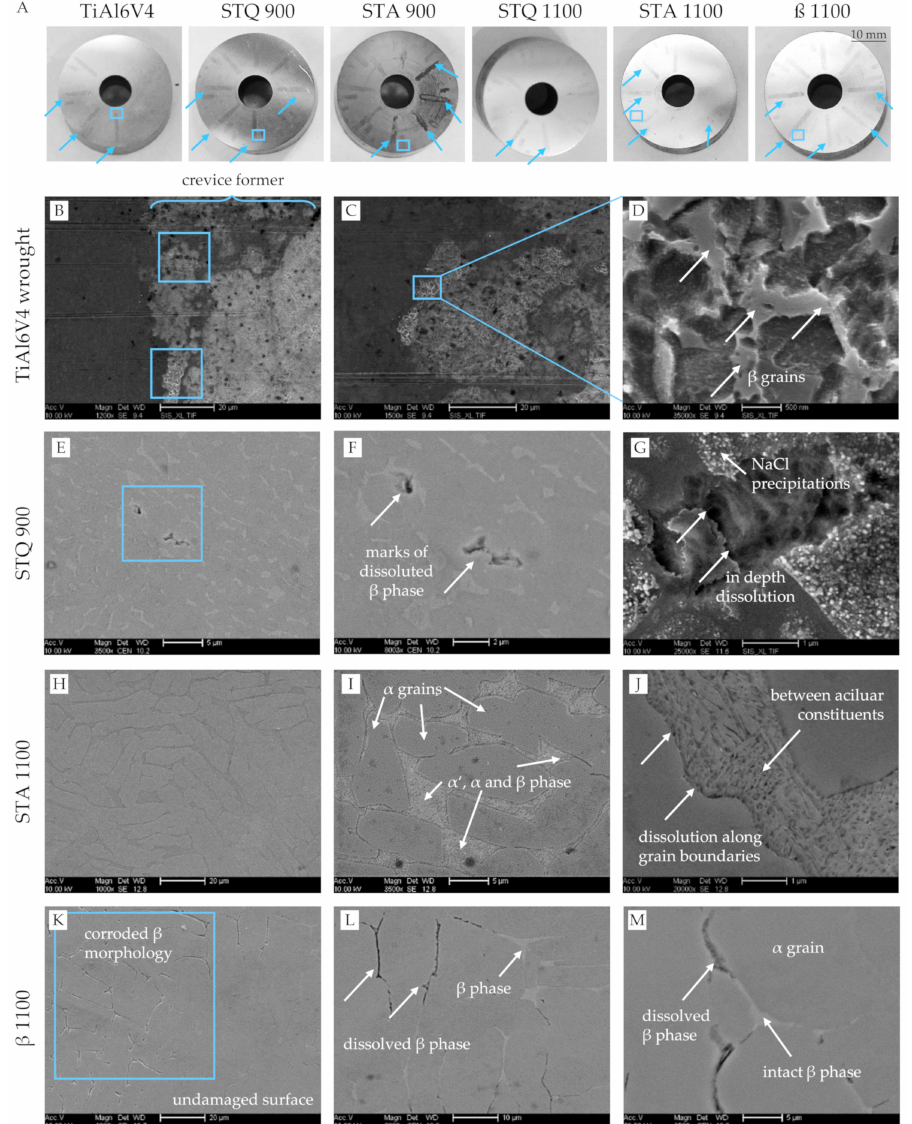
Figure 7. TiAl6V4 sample surfaces after crevice corrosion testing under severe inflammatory conditions simulated by four-week immersion in PBS with HCl and H 2 O 2 additives at 37 ◦ C. ( A ) Representative photographs show macroscopic crevice-related damaged on heat-treated TiAl6V4 sample surfaces (indicated by blue arrows). All samples are placed with the crevice position 1 at the top [29]. The blue boxes indicate the regions of interests investigated by SEM. ( B – M ) Electron micrographs of representative crevice areas for ( B – D ) TiAl6V4 wrought alloy indicate a selective